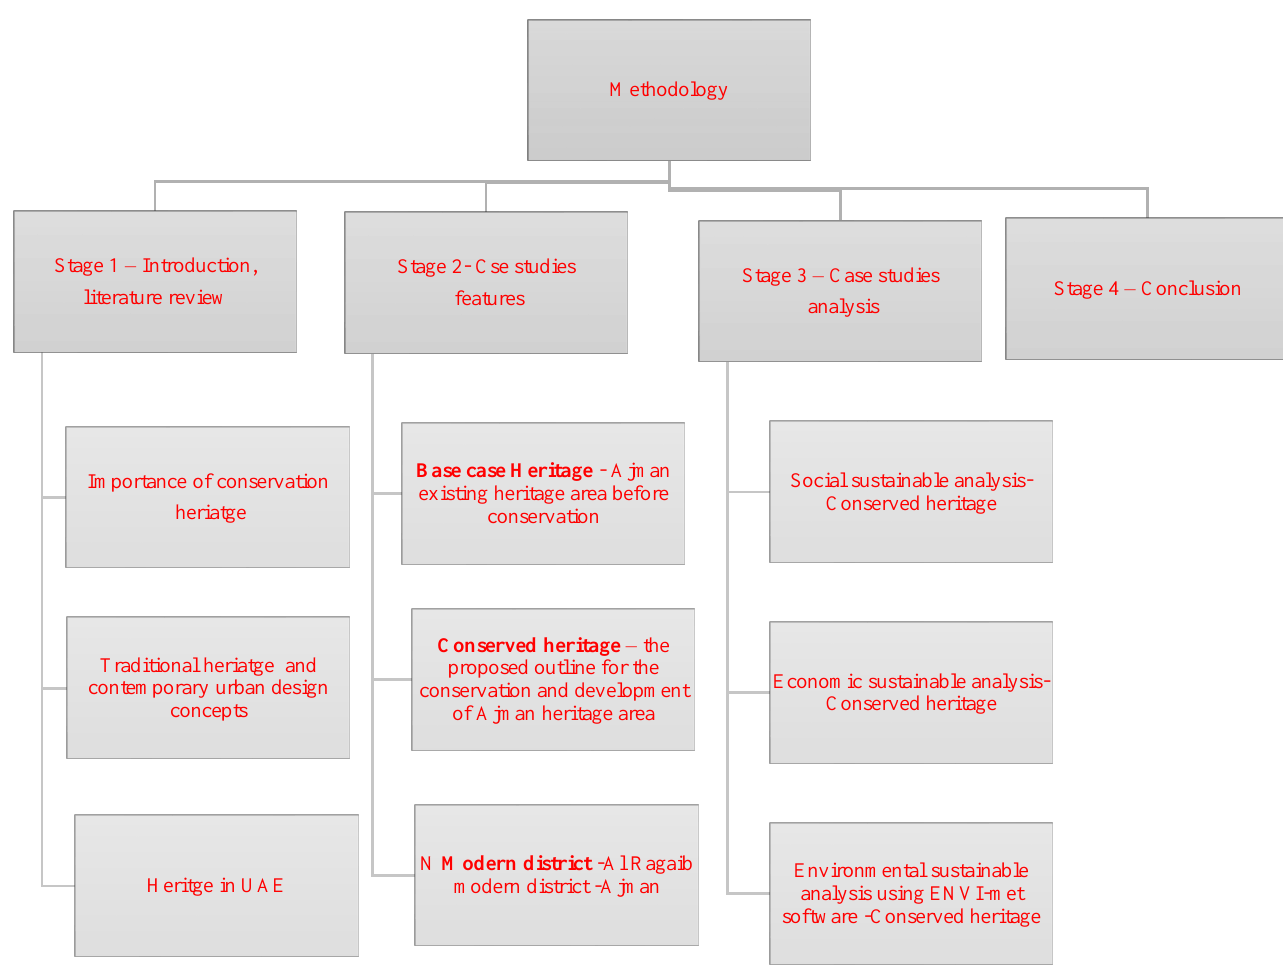
Figure 2. Methodology outline of the research.